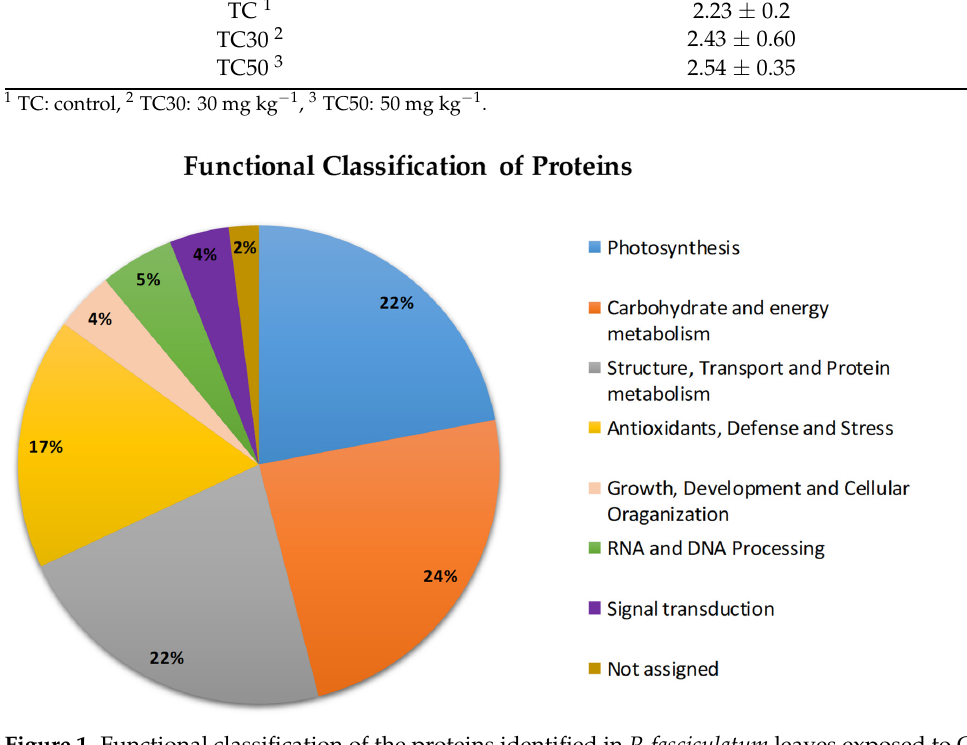
Table 1. Protein yield from Paspalum fasciculatum leaves exposed to Cd stress for 60 days ( n = 3). Treatments